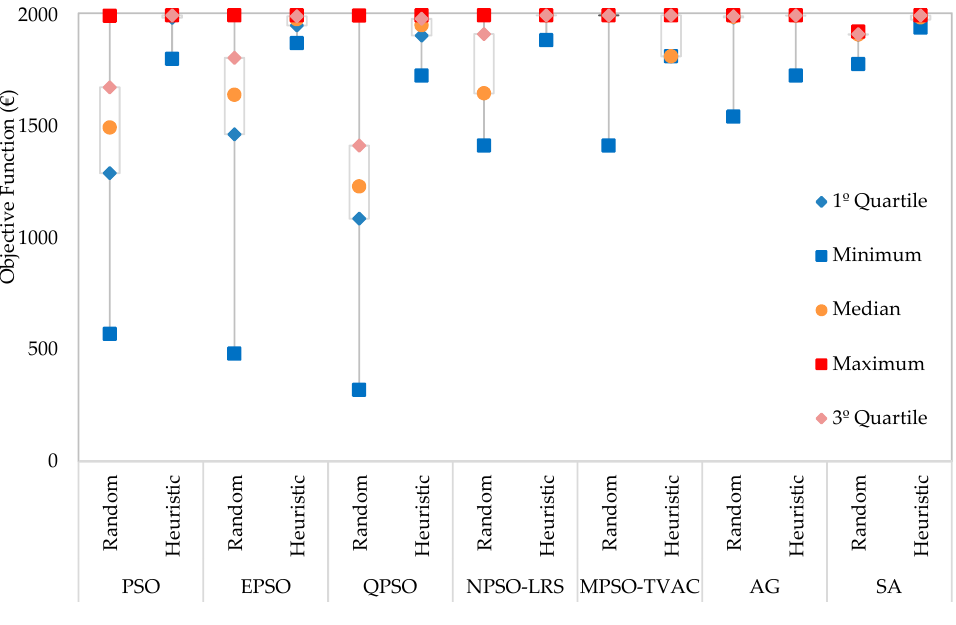
Figure 2. Box plot for the applied methods .